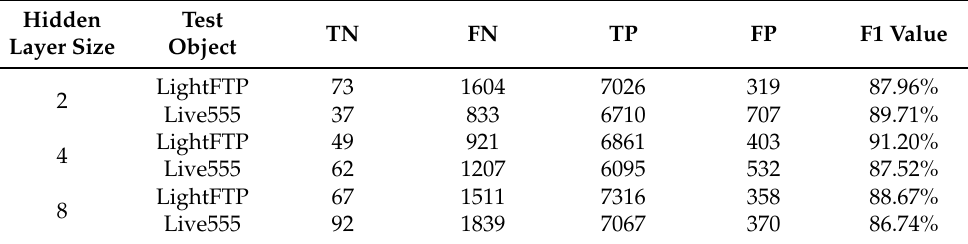
Table 5. Classification performance of the test case filter under different hidden layer